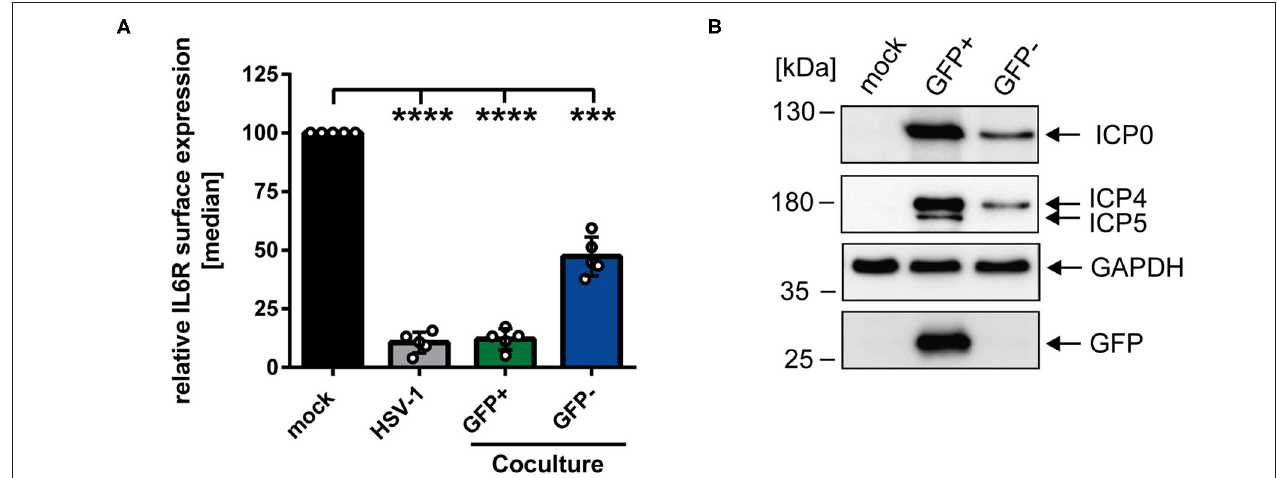
FIGURE 2 | HSV-1-mediated IL6R modulation is transmittable from directly-infected GFP-positive to uninfected GFP-negative bystander mDCs. (A) Mature DCs were mock- or HSV-1 wt-infected (MOI of 5), all samples were trypsinized at 3 hpi and subsequently cocultured with uninfected mDCs at 6 hpi. HSV-1 wt-infected mDCs were included as a positive control (“HSV-1,” gray bar). Cells were harvested 24 hpi, stained with an IL6R-specific antibody and analyzed by cytometry. Distinction between infected and uninfected mDCs is based on the GFP signal and the used gates in data evaluation software FCS Express 5, which are specific for either the GFP-positive or GFP-negative population. IL6R surface expression is shown as median and normalized to the mock condition. The experiment was performed five times with cells derived from different healthy donors. Error bars indicate SD. Significant changes were analyzed using a one-way ANOVA and Bonferroni multiple comparison post hoc tests and are indicated by asterisks (*** p ≤ 0.001, **** p ≤ 0.0001). (B) Mature DCs were mock- or HSV-1 wt-infected (MOI of 0.6) and harvested 16 hpi. Subsequently, cells were sorted based on their GFP expression into GFP-positive and GFP-negative mDC fractions. Protein lysates of sorted cells were analyzed using Western blot for detection of ICP0, ICP4, ICP5, GFP, and GAPDH as loading control. The experiment was performed three times with cells derived from different healthy